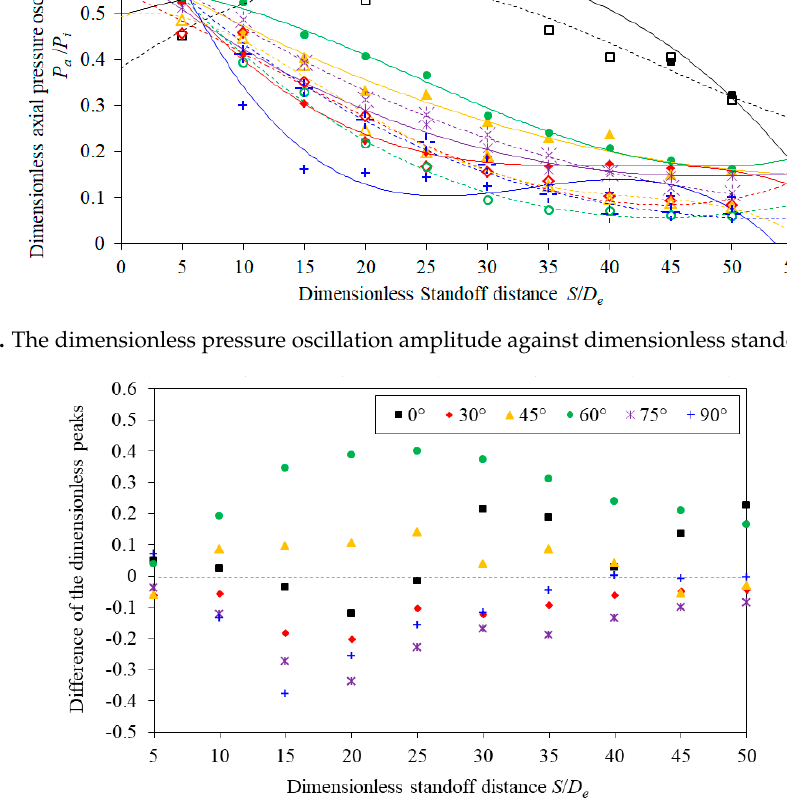
Figure 9. The differences in the dimensionless P max against dimensionless S . Appl. Sci. 2019 , 9 , x